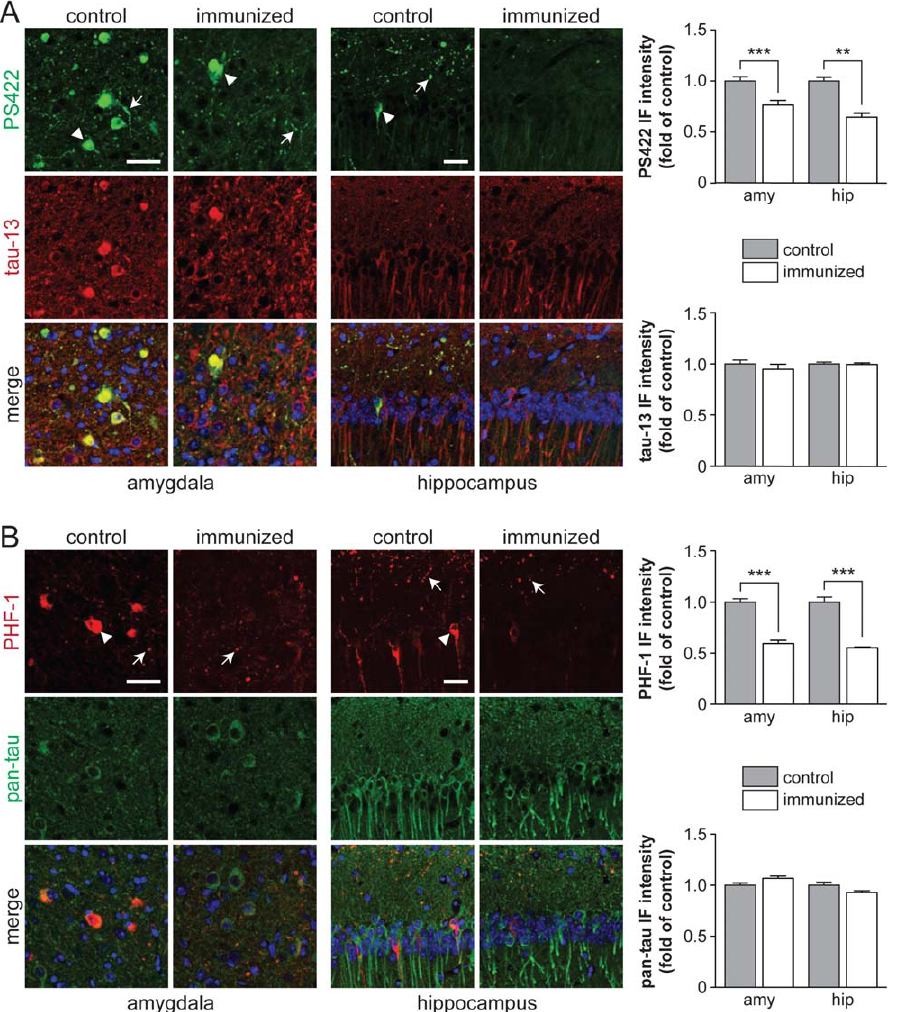
Figure 2. Tau-targeted immunization reduces tau phosphorylation in pR5 mice. ( A ) Immunohistochemistry (IHC) of coronal brain sections obtained from 17 months-old pR5 mice (group II) that have been immunized 9 months ago (immunized) or were control injected (control), stained with antibodies to total human tau (tau-13) and tau phosphorylated at Ser422 (PS422). Representative pictures from amygdala (left) and CA1 region of the hippocampus (right) were taken at the same exposure. Several neurons stained intensively with PS422 in these brain areas of control pR5 mice (arrowheads). Similarly, PS422 stained dystrophic neurites (arrows). In contrast, numbers of PS422-positive neurons in amygdala and hippocampus, as well as staining of dystrophic neurites in the hippocampus were strongly reduced in immunized pR5 mice, indicating reduced pathological phosphorylation of tau. Note that the staining pattern with tau-13 is comparable in control and immunized pR5 amygdala and hippocampus, suggesting similar levels of total tau. Merged pictures include nuclear DAPI staining. Scale bars, 50 m m. Graphs: Quantification of immunofluoresence intensity in total amygdala and CA1 region of the hippocampus shows significantly reduced PS422 staining in immunized compared to control pR5 mice, while tau-13 staining is similar (**, p , 0.001; ***, p , 0.0001). ( B ) Similar to PS422, an antibody to tau phosphorylated at Ser396/Ser404 (PHF-1) stained numerous neurons (arrowheads) and dystrophic neurites (arrows) in the amydala and hippocampus of control pR5 brains. Much less neurons in amygdala and hippocampus and dystrophic neurites in the hippocampus stained with PHF-1 in immunized pR5 mice, indicating reduced levels of tau phosphorylation at Ser396/Ser404. Staining for total tau (pan-tau; green) was comparable in control and immunized pR5 mice, suggesting again unchanged total tau levels. Scale bars, 50 m m. Graphs: Quantification of immunofluoresence intensity in total amygdala and CA1 region of the hippocampus shows significantly reduced PHF-1 staining in immunized compared to control pR5 mice, while pan-tau staining is similar (***, p , 0.0001). (group I: p , 0.001, groups II/III: p , 0.0001) ( Fig. 3 B ). For